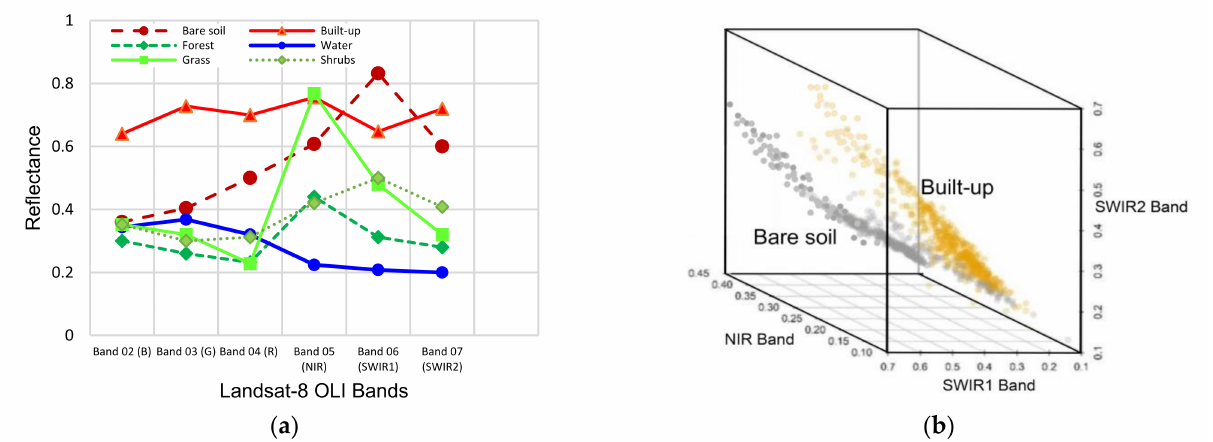
Figure 2. ( a ) Spectral profiles for bare-soil, urban built-up, vegetation and water bodies. ( b ) 3D plot for bare soil and built-up areas in NIR and SWIR spectral